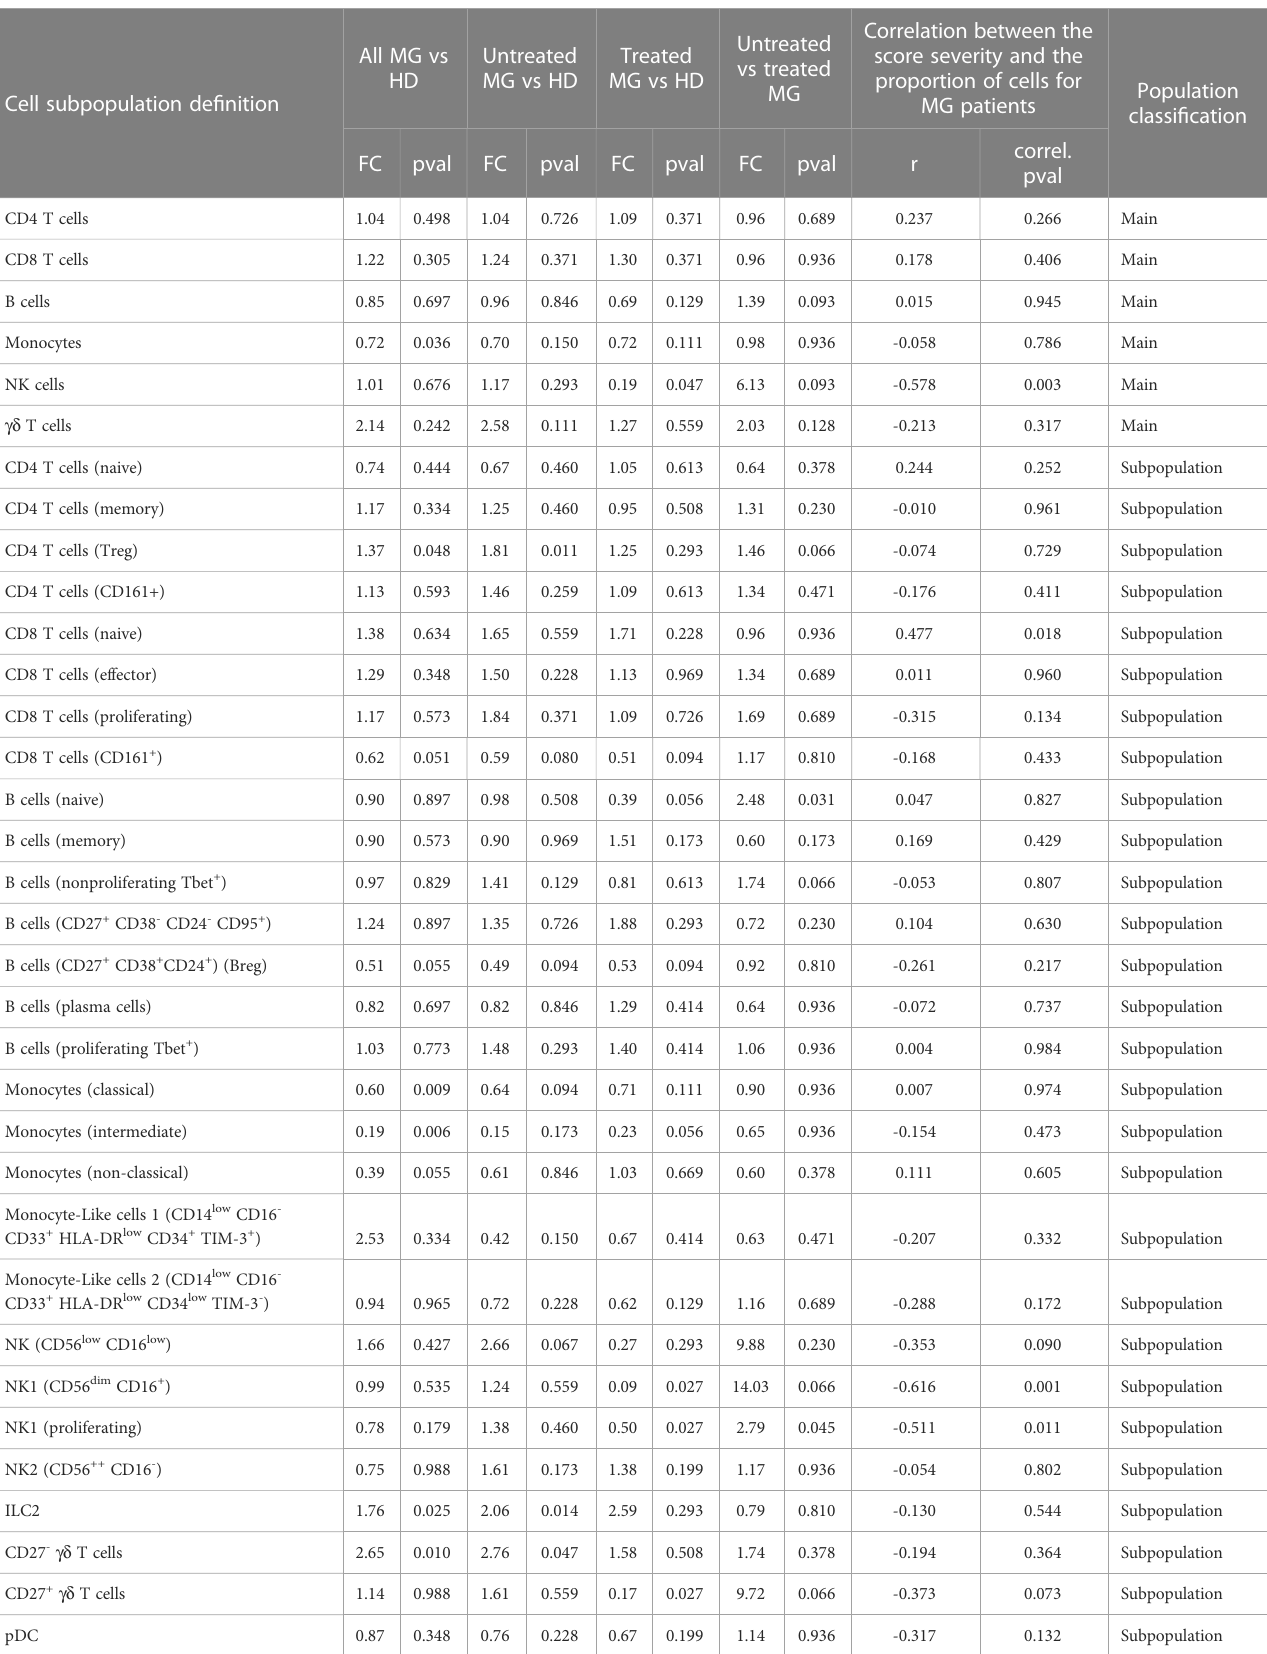
TABLE 1 Comparison of proportion of cell subpopulations between different subgroups of